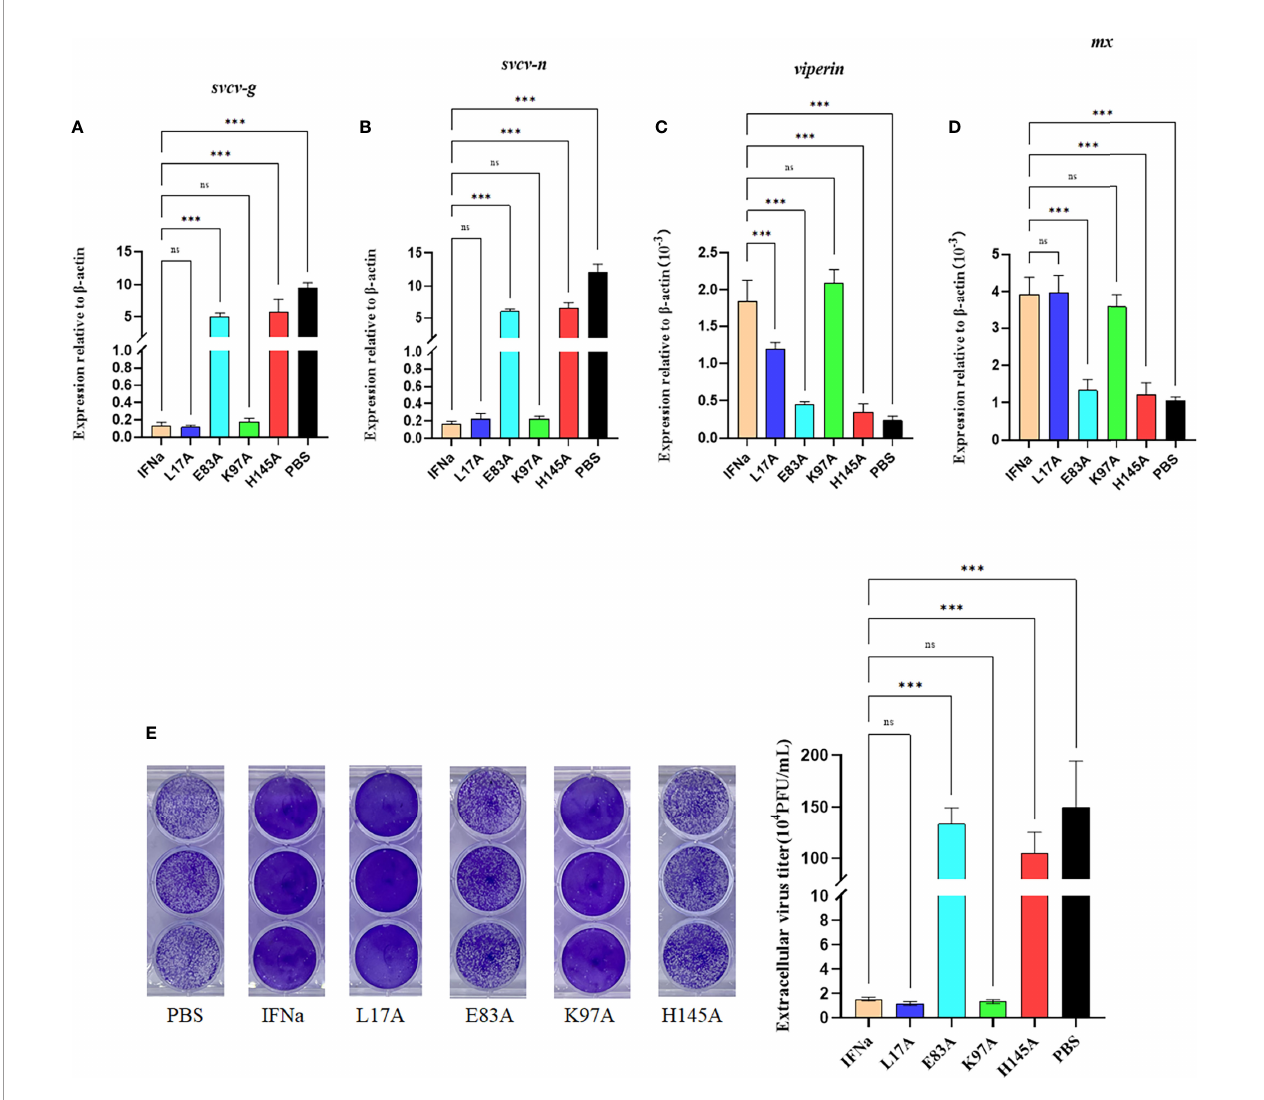
FIGURE 9 | Mutation of E103A and H165A reduces the antiviral activity. The EPC cells were incubated with wild-type IFNa, L27A, E103A, K117A, or H165A proteins for 6 h and then infected with SVCV (MOI = 0.1). After 24 h, total RNA was extracted for analysis of the mRNA levels of svcv-g (A) , svcv-n (B) , viperin (C) , and mx (D) . Data are shown as mean + SEM (N = 4). ***P < 0.001 is considered signi fi cant. ns, no signi fi cant difference. The EPC cells were incubated with wild- type IFNa, L27A, E103A, K117A, and H165A proteins for 6 h and then infected with SVCV (MOI = 1). Culture media from infected EPC cells were collected for plaque formation assay using EPC cells. Experiments were performed three times with similar results (E)